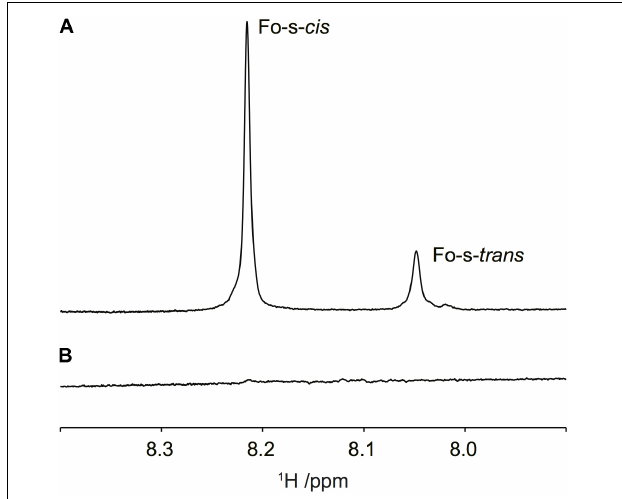
FIGURE 3 | Ba::Tn7 wbdR (cid:49) wbkC PS lacks N -formyl groups in the O-PS. 1 H NMR spectral region of formyl resonances of (A) Ba::Tn7 wbdR PS and (B) Ba::Tn7 wbdR (cid:49) wbkC